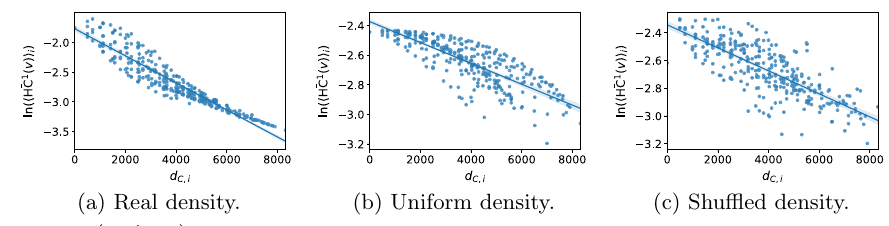
� ¯ HC 1 ( v ) � i Fig. 4 ln versus d C , i , for different population (cid:30) (cid:31)